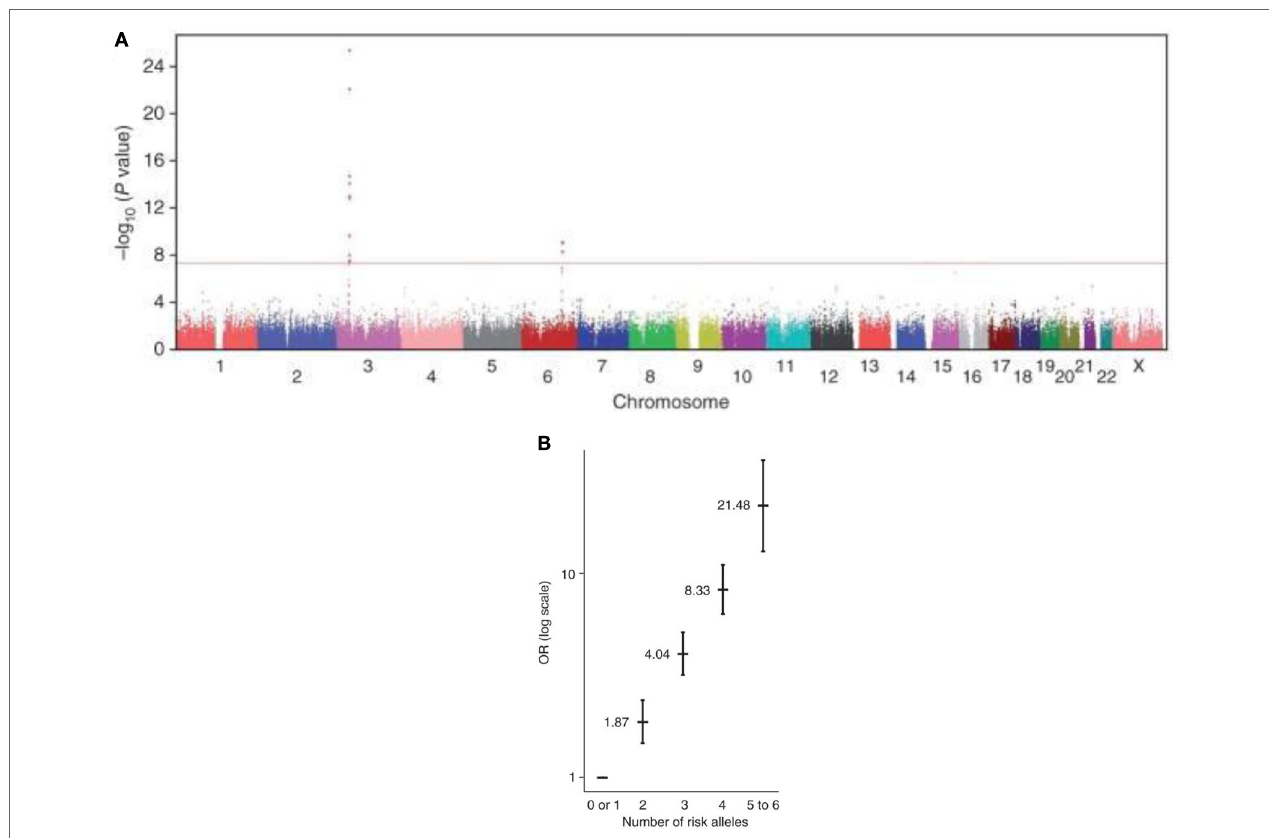
FiGURe 4 | A genome-wide association study on BrS . Modified from Ref. (101). (A) Manhattan plot revealing signal associations between two SNP (SCN10A and HEY2) and BrS. Statistical significance is represented with a red line ( P = 5 × 10 − 8 ). A third haplotype of SCN5A reached genome-wide significance after replication analysis. (B) The cumulative effect of the six common risk alleles on susceptibility to BrS. Odds Ratio (OR) is plotted on the vertical axis and the cumulative number of alleles (from 0 to 6) in horizontal